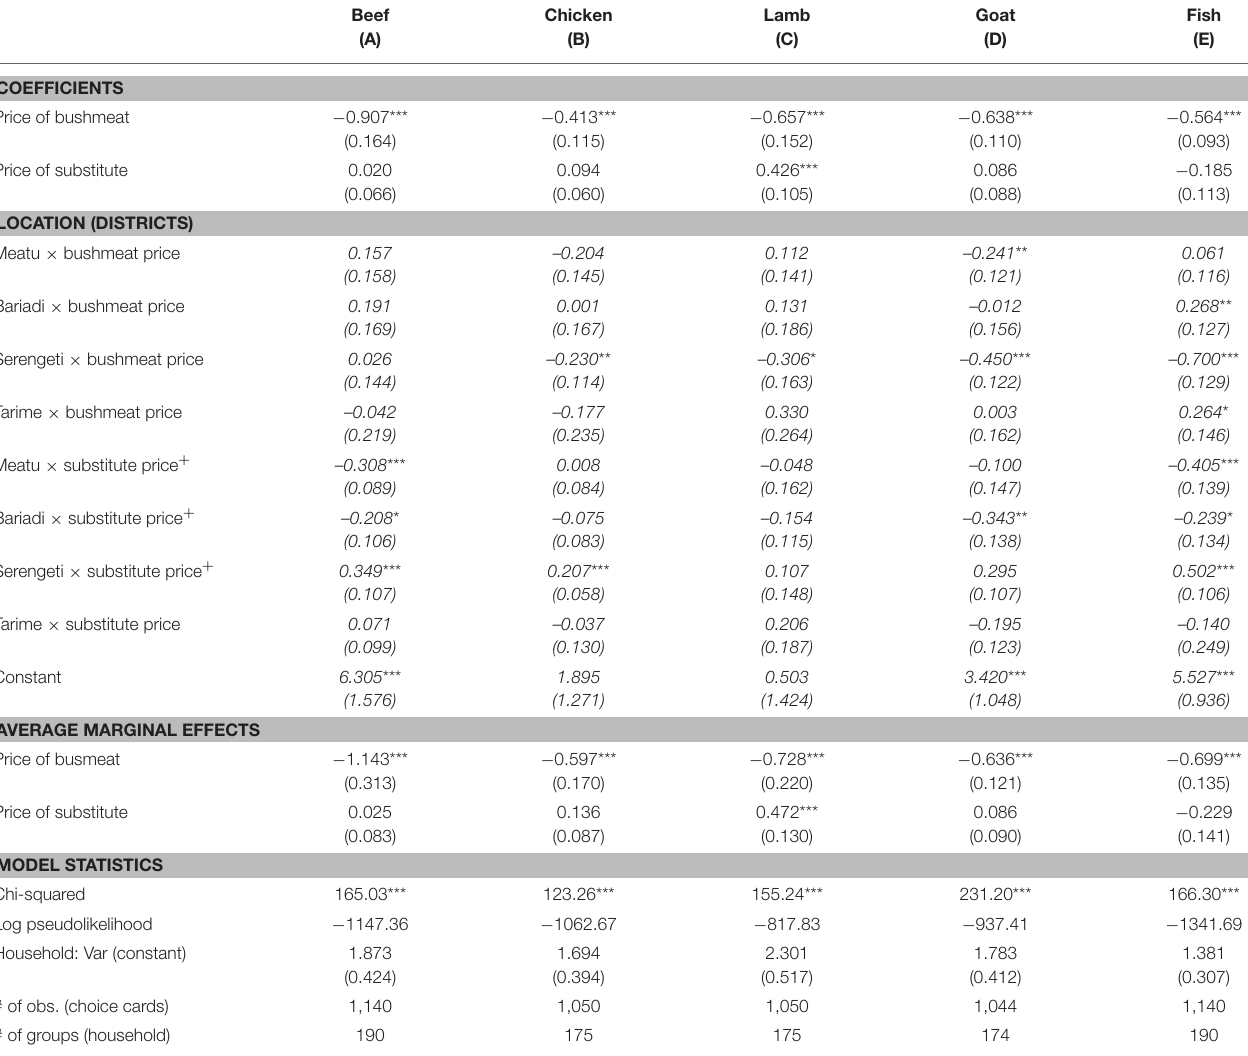
TABLE 5 | Coefficients of the mixed effects Poisson models representing the own and cross-price elasticities of bushmeat demand for individual substitute meat types contingent on district effects.